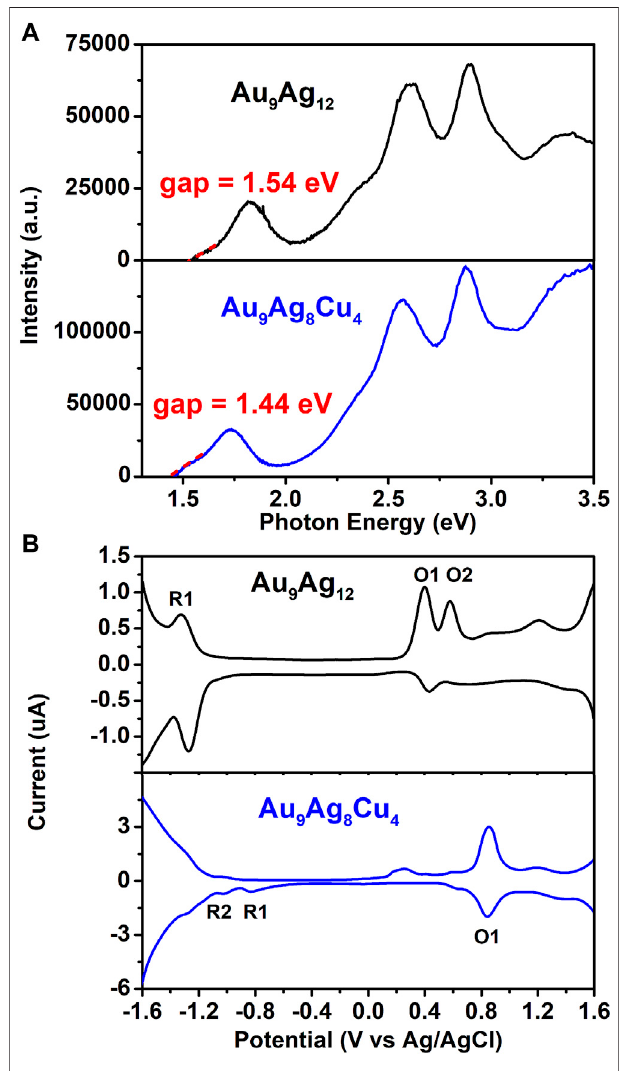
FIGURE 5 | (A) Photon energy spectra of Au 9 Ag 12 (black line) and Au 9 Ag 8 Cu 4 (blue line). (B) DPV of Au 9 Ag 12 (black line) and Au 9 Ag 8 Cu 4 (blue